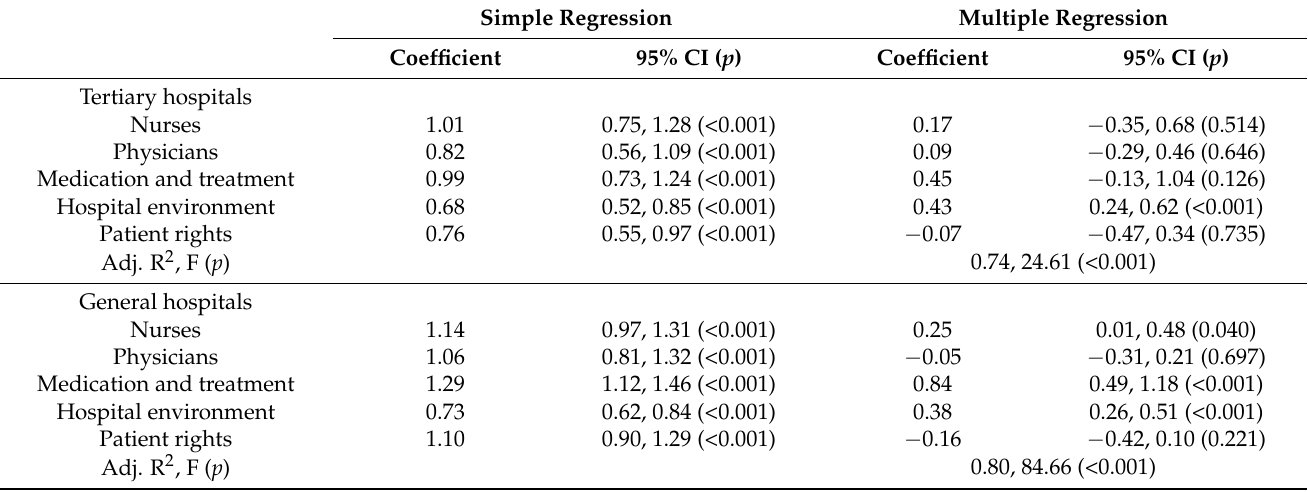
Table 4. Effects of each patient experience dimension on overall hospital rating (n = 146). Simple Regression Multiple Regression Coefficient 95% CI ( p ) Coefficient 95% CI ( p